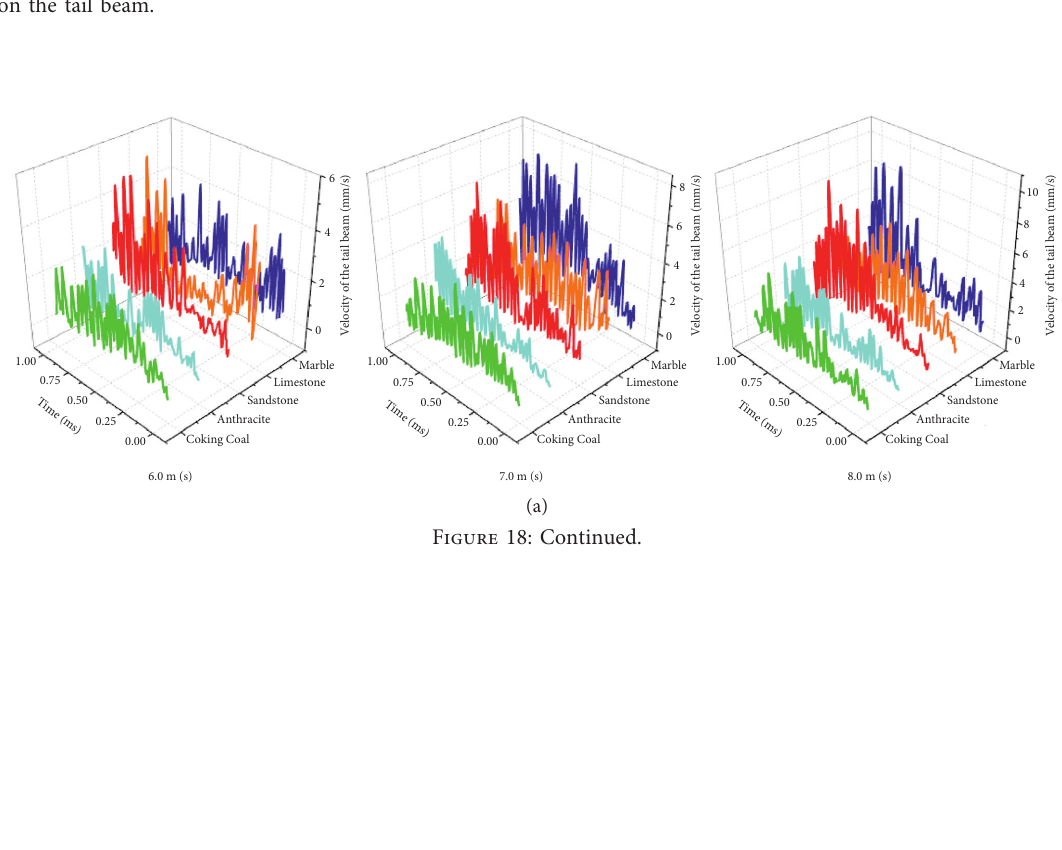
Figure 17: Simulation data of impact process. (a) Energy consumption of coal gangue particle failure. (b) The impact force of coal gangue particles on the tail beam.